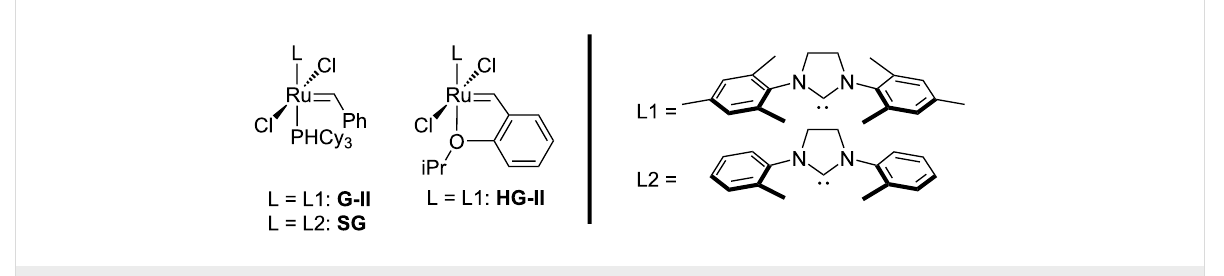
Figure 2: Structure of metathesis catalysts.